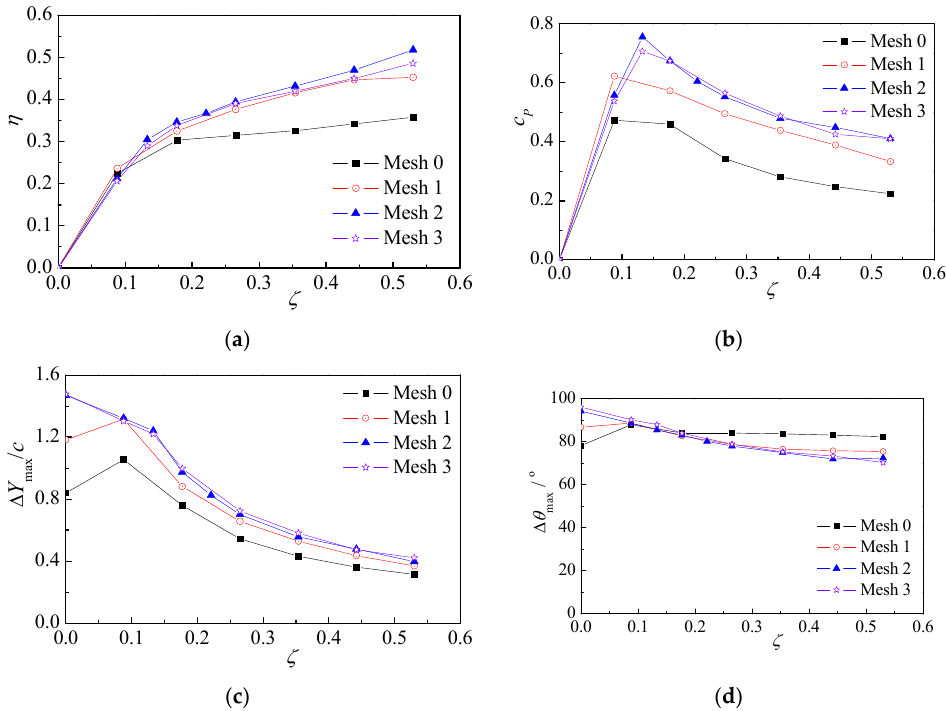
Figure 5. Hydrodynamic performance and motion metrics of flapping hydrofoil as functions of the damping coefficient with four different mesh refinement schemes: ( a ) hydraulic efficiency; ( b ) power coefficient; ( c ) heave amplitude; ( d ) pitch amplitude.